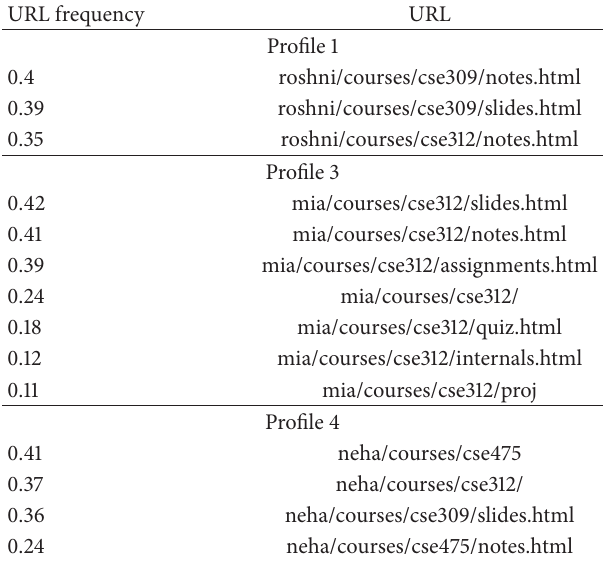
Table 2: Sample user profiles generated by WebBluegillRecom- annealing algorithm with ICTF = 0.1 and Clus threshold = 10.